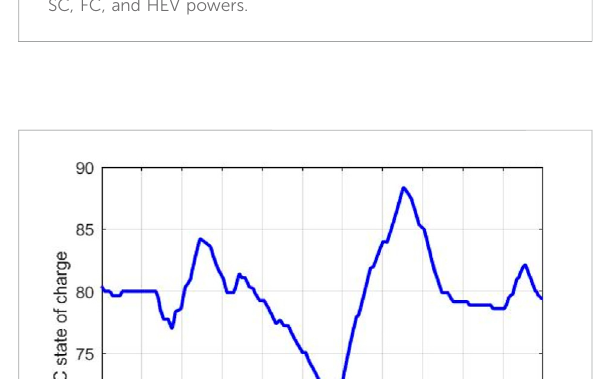
FIGURE 14 SC, FC, and HEV powers. FIGURE 15